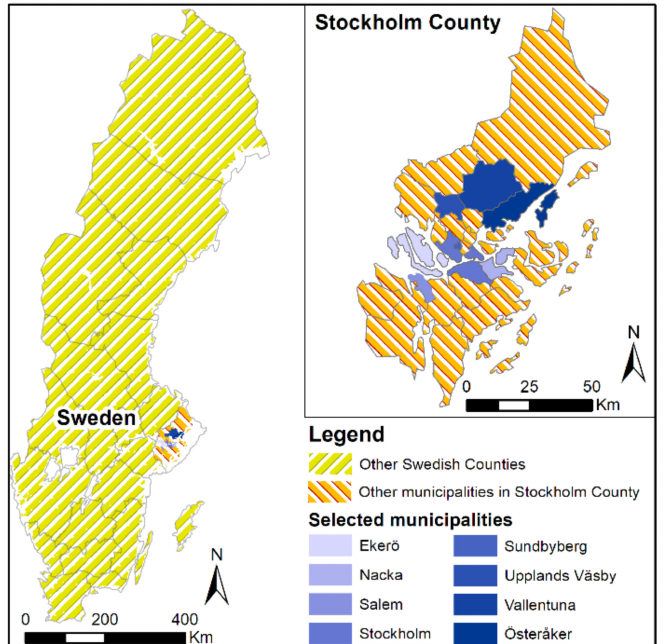
Figure 1. A map of selected municipalities in relation to other municipalities in Stockholm County and other Swedish